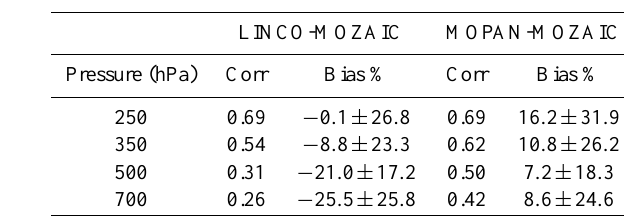
Table 1. Mean correlation bias and standard deviation in % between MOZAIC aircraft CO data set and the LINCO run and between